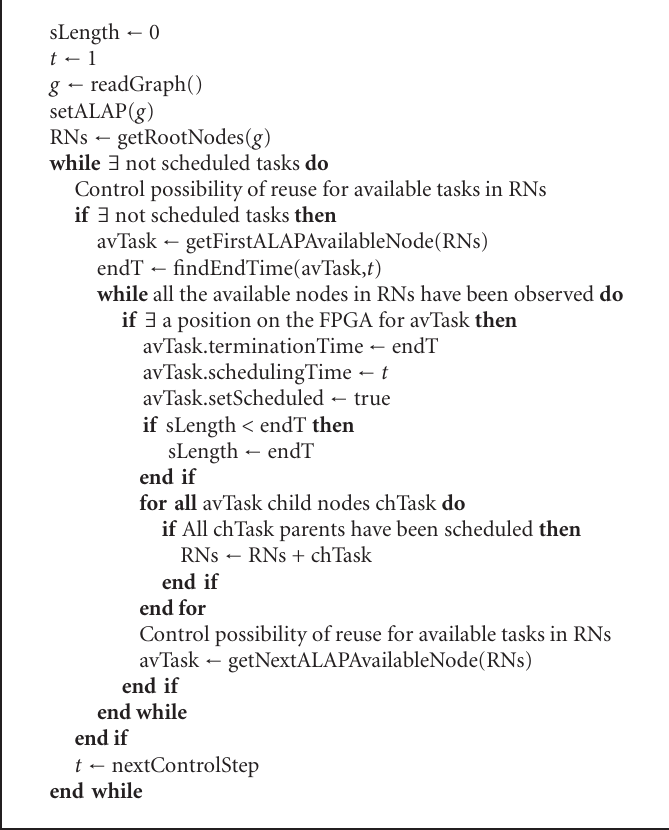
Algorithm 1: Heuristic